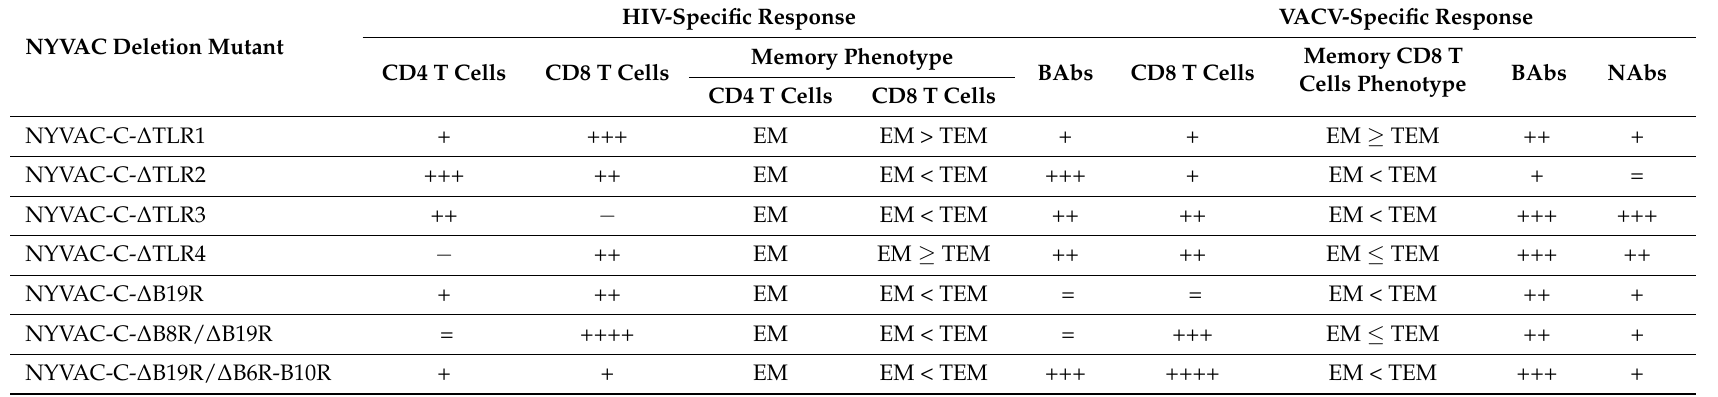
Table 3. T cell phenotype and antibody responses induced by the different NYVAC deletion mutants. HIV-Specific Response VACV-Specific NYVAC Deletion Mutant